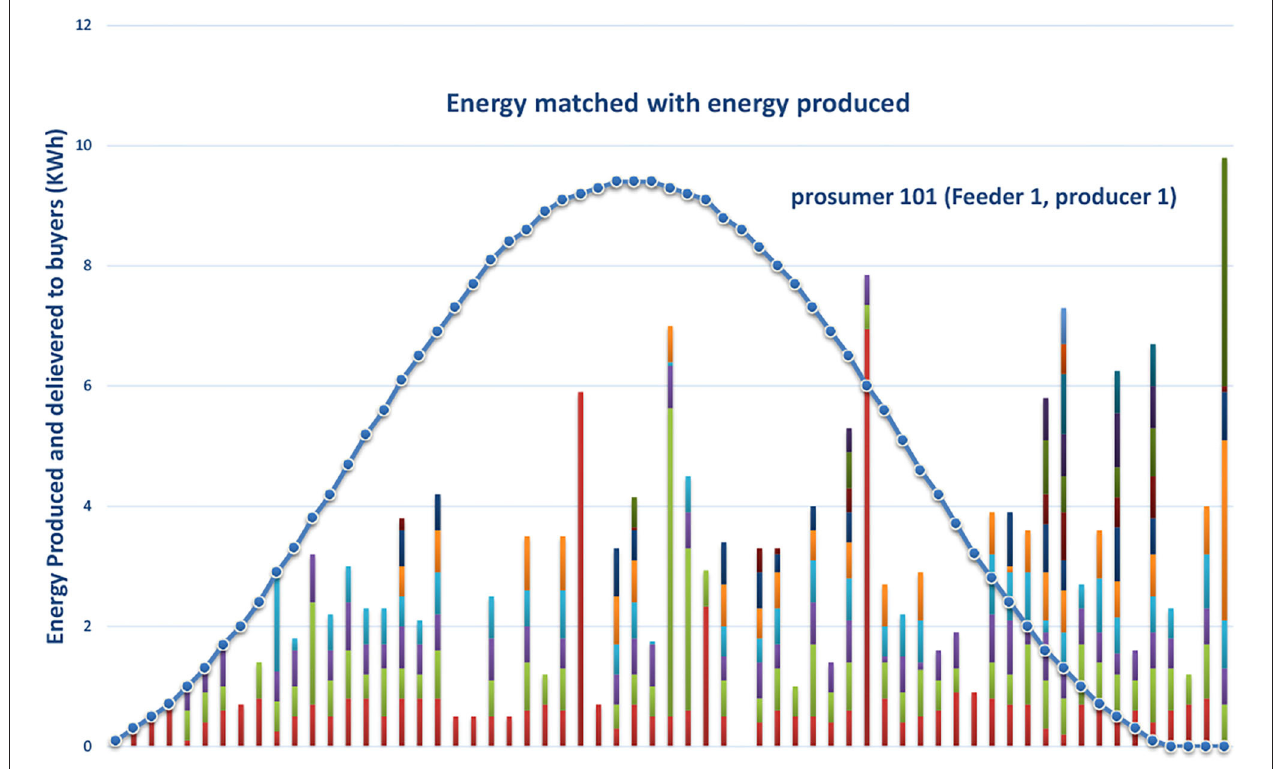
FIGURE 10 | Energy generated in each interval (blue line) and energy traded to a set of consumers in each interval (vertical bars) for the first prosumer of the first feeder (test case C).